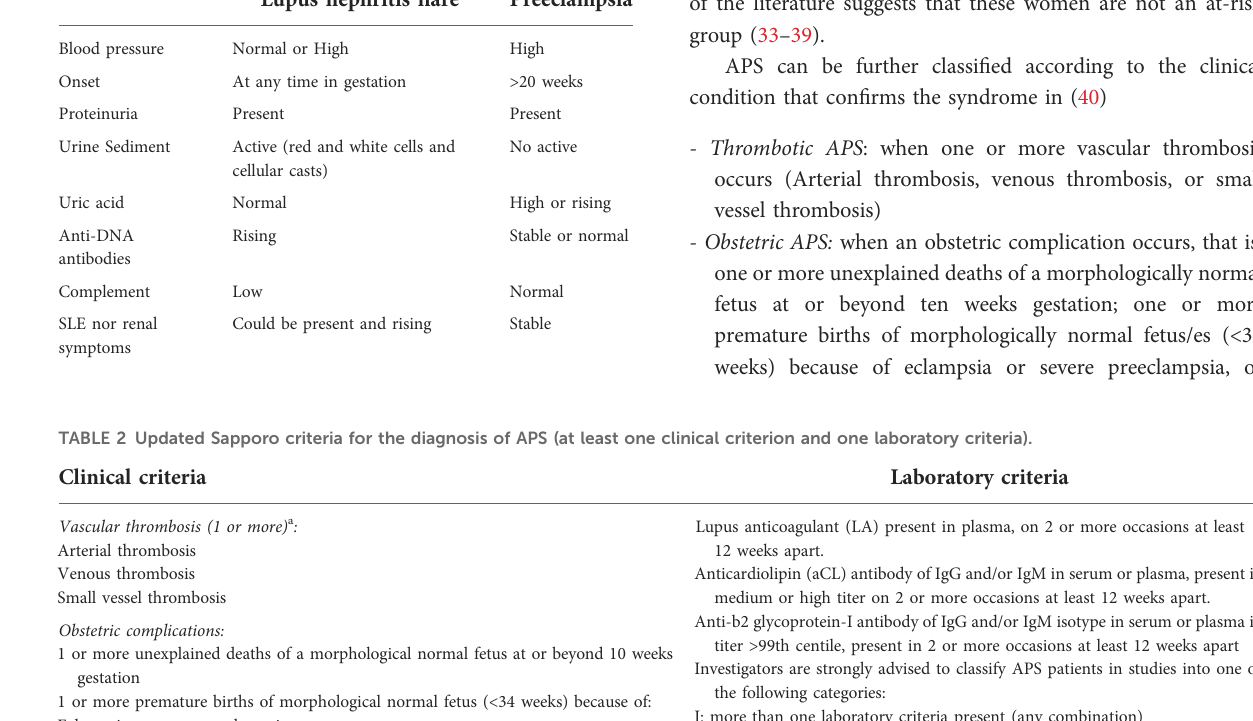
TABLE 1 Lupus nephritis fl are vs. preeclampsia. Lupus nephritis fl are Preeclampsia